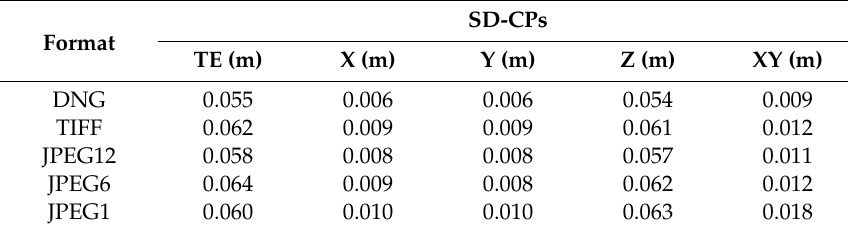
Table 6. Evaluation of the accuracy on control points (CPs)–Test site 1.